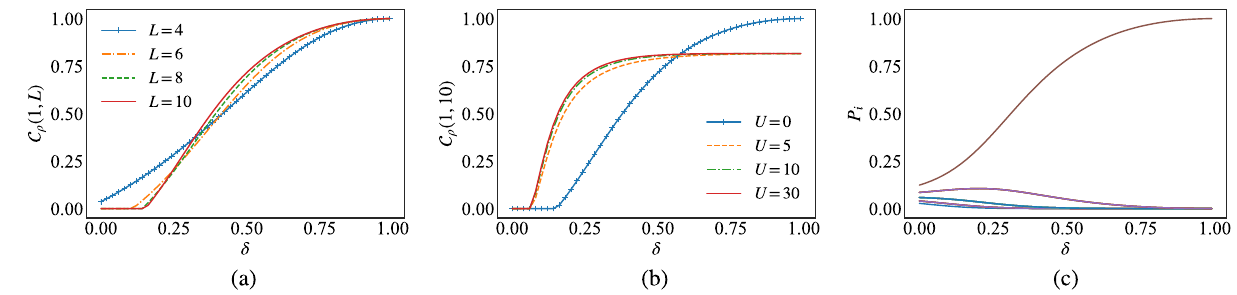
Figure 2. ( a )+( b ) The end-to-end concurrence, Eq. (13), with respect to δ for different chain sizes L , and for various values of U with fixed L , respectively. ( c ) Evolution of the occupation probabilities P i of the local half filled state with respect to δ